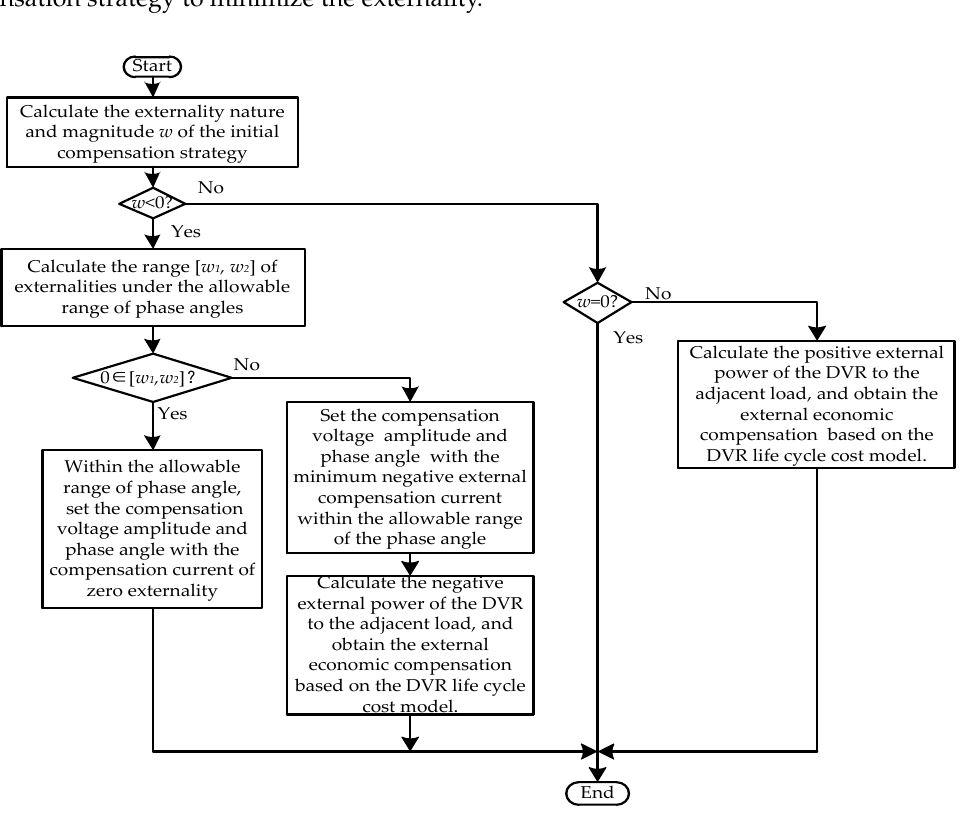
Figure 10. Flow chart of optimized compensation strategy.